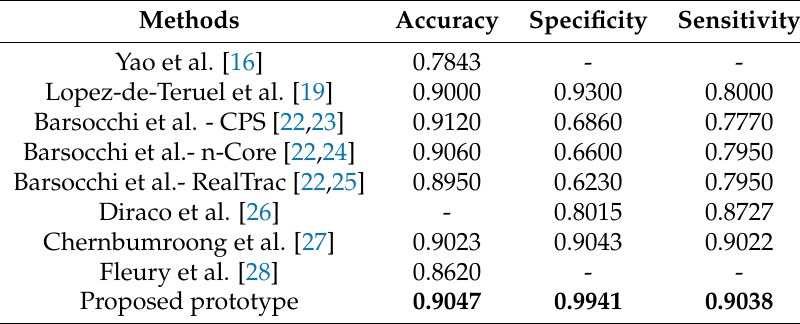
Table 4. Comparison of outcomes with other state-of-art